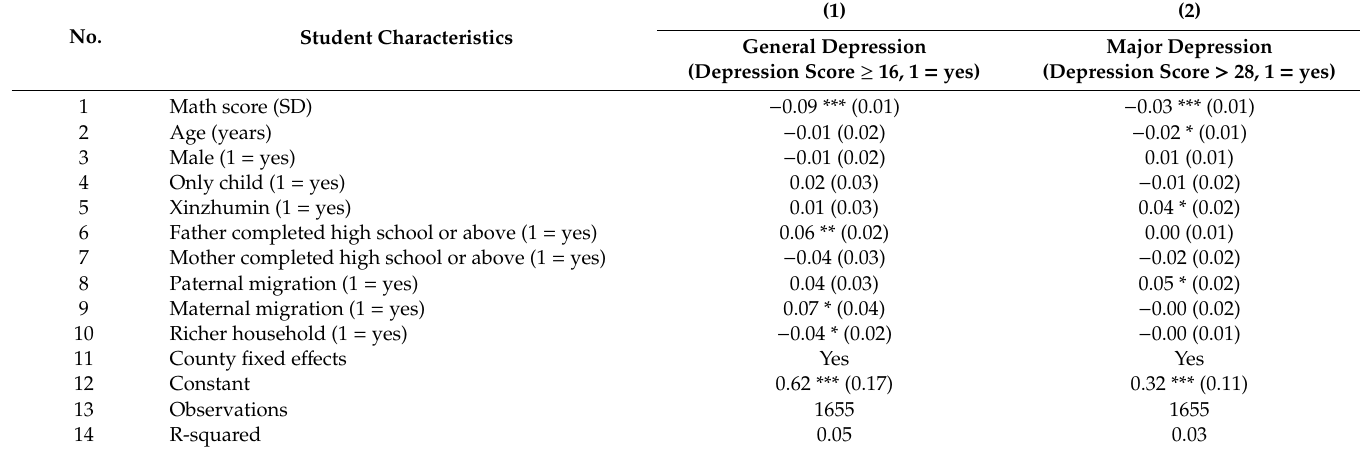
Table 4. OLS regression on correlation between depressive symptoms and academic performance across di ff erent levels of